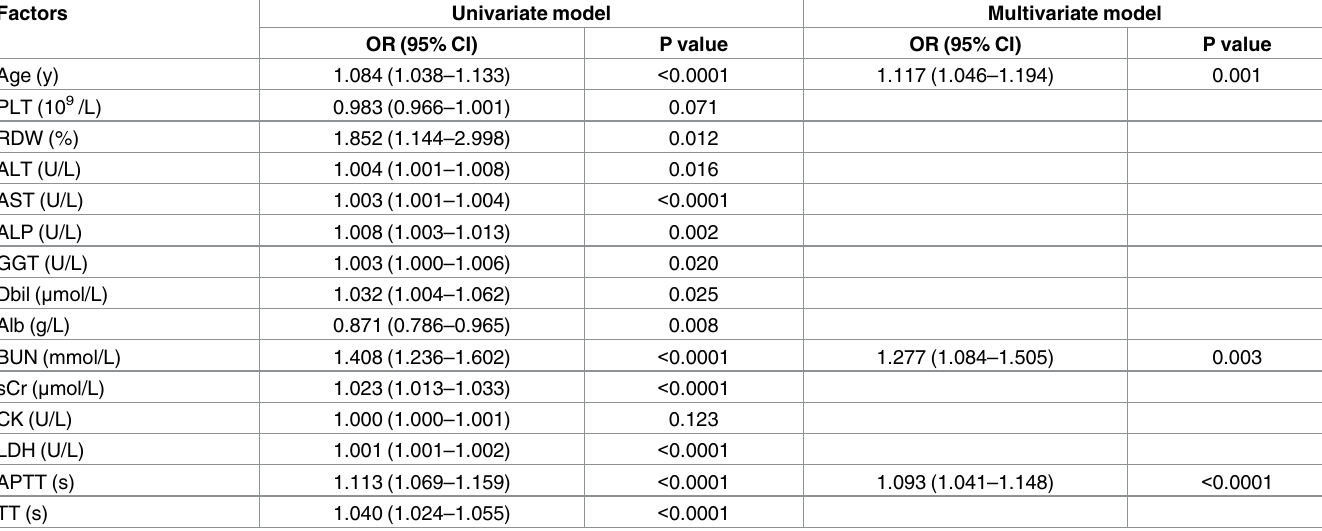
Table 3. Univariate and multivariate analysesof features associated with mortality in SFTS patients.